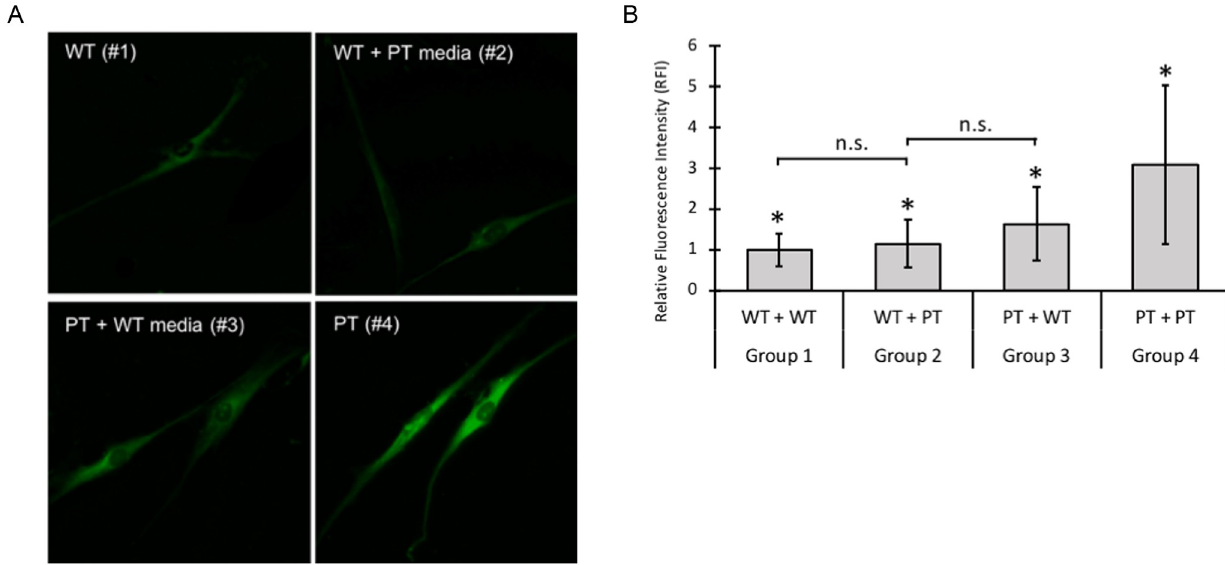
Fig 3. A. Fluorescence analysis of autofluorescence storage material in four conditioned media groups. Autofluorescence is higher in PPT1-deficient cells grown in either condition 3 or 4 as compared to WT cells grown in either WT or PT-conditioned media (condition 1 or 2). Cells were stained with DAPI at 1:1000 to use as a reference for locating and focusing on cells. Cells were then imaged using the GFP (ex 488nm / em 530nm) filter. B. Quantitative analysis of autofluorescence storage material in four conditioned media groups. RFI was measured using ImageJ (n = 2 replicates per group). Significant differences (denoted by � , p < 0.001) were found between all conditioned groups, with the exception of group 1 vs 2, and group 2 vs 3, which are labeled n.s (not significant). Error bars indicate +/-